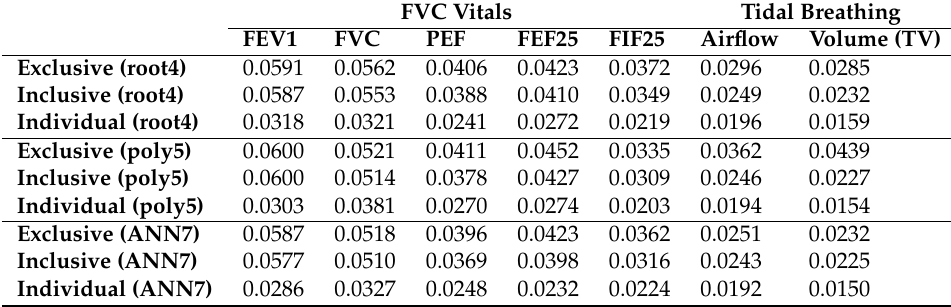
Table 4. δ value of FVC vitals and tidal breathing comparison (The smaller The better). FEV, forced effective volume; PEF, forced peak expiratory flow; FEF, forced expiratory flow; FIF, forced inspiratory flow; TV, tidal